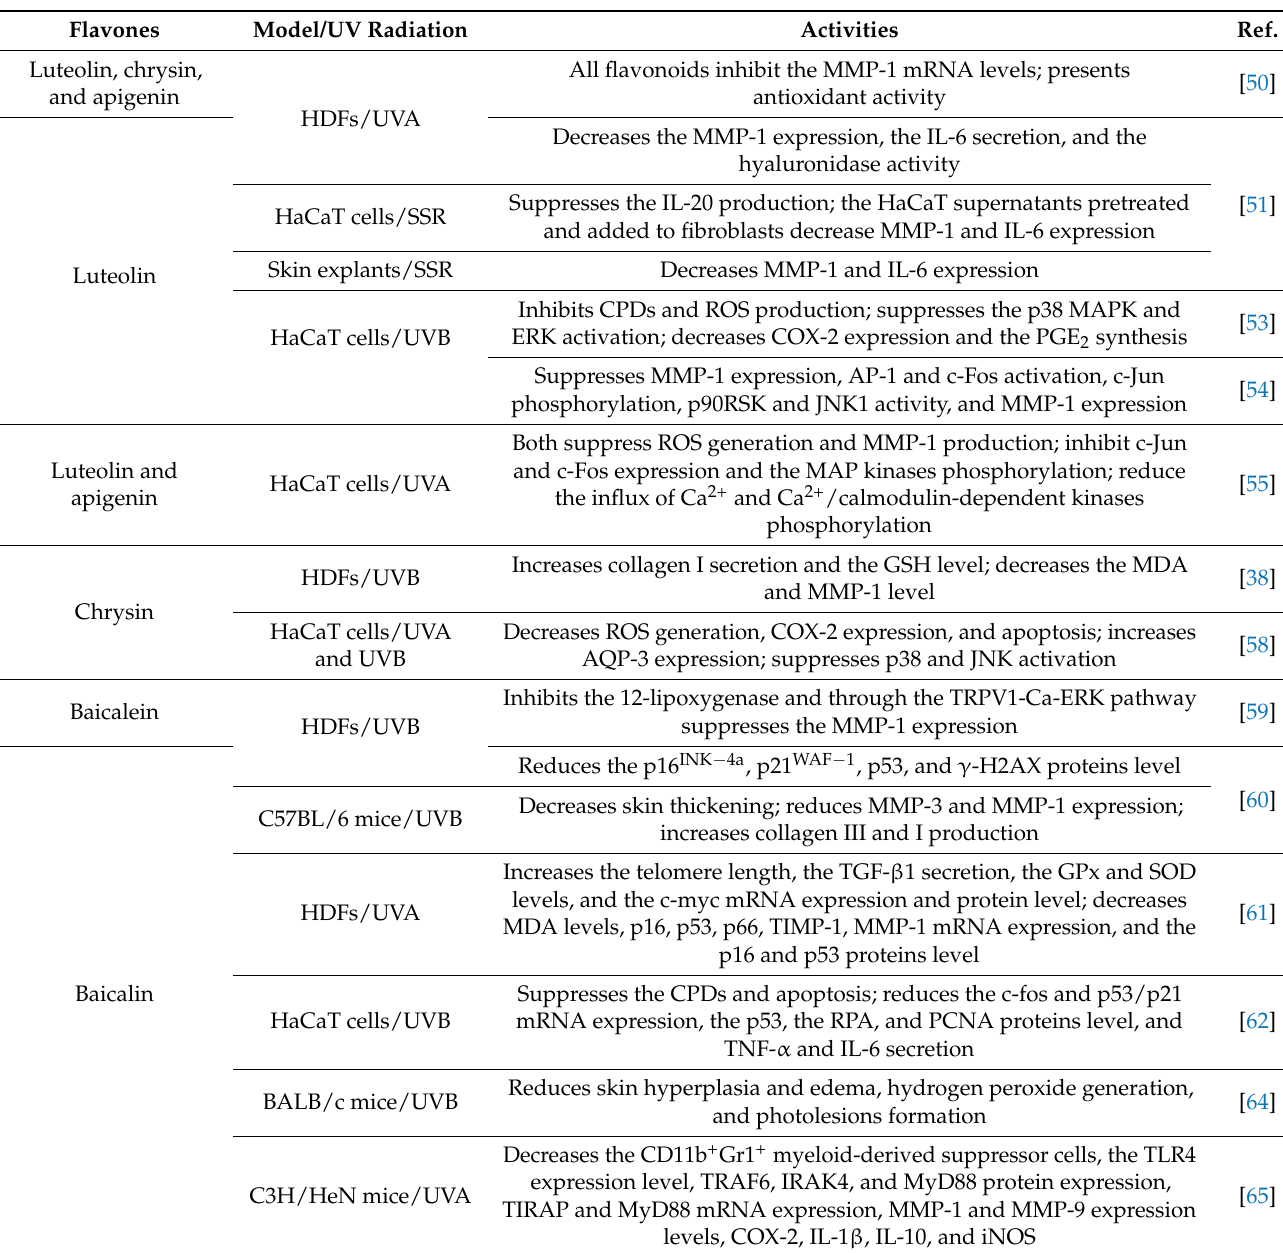
Table 1. Anti-photoaging properties of flavones reported in in vitro and in vivo